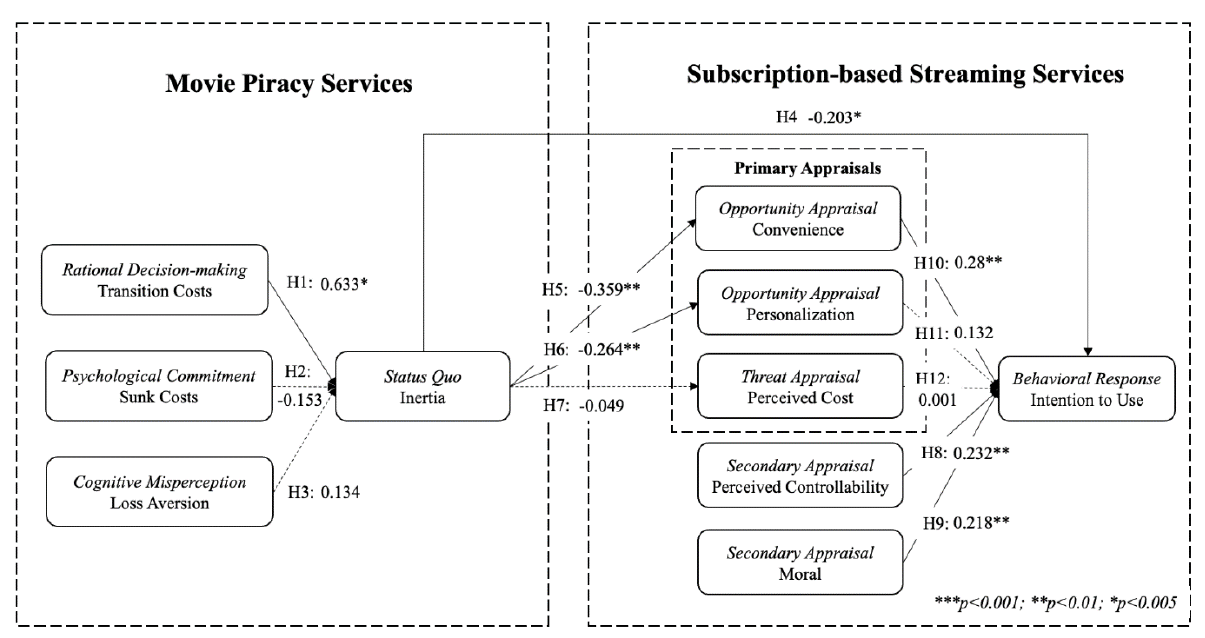
Figure 4. Final research